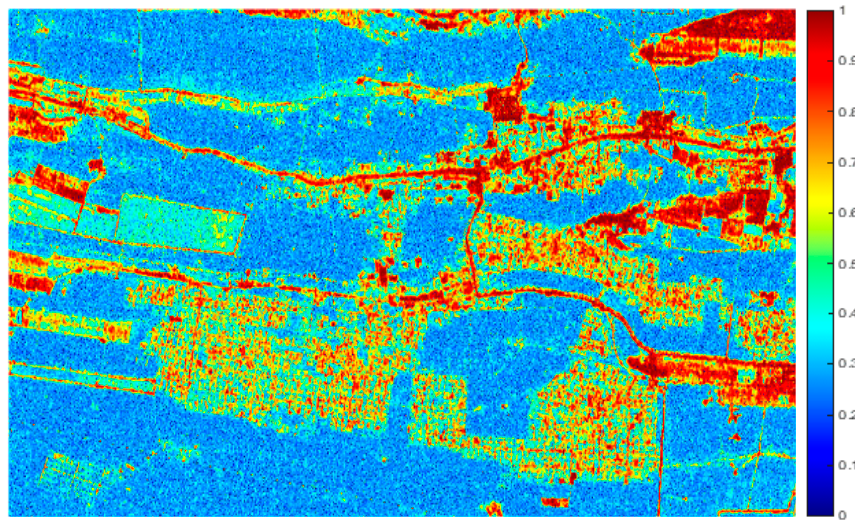
Figure 12. The original and optimum phase of DSs.